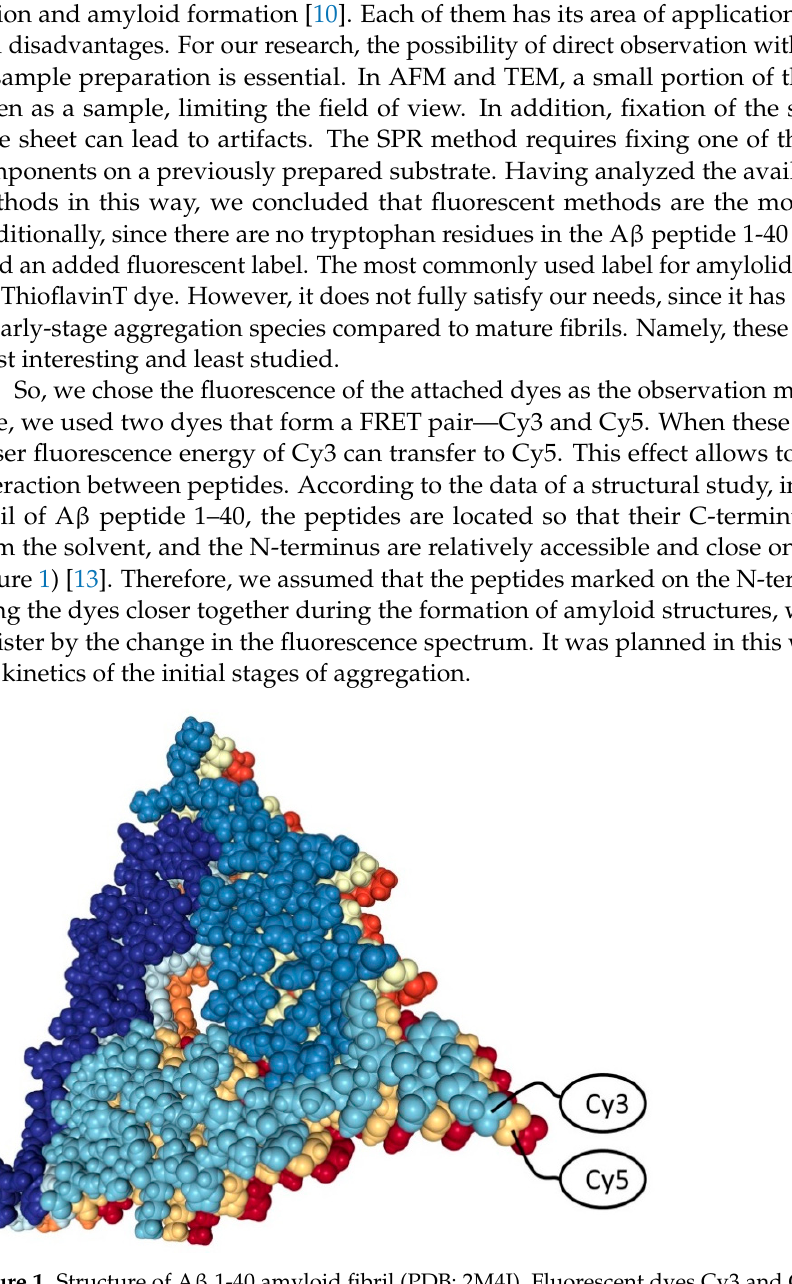
Figure 1. Structure of A β 1-40 amyloid fibril (PDB: 2M4J). Fluorescent dyes Cy3 and Cy5 attached to the N terminus of peptides are schematically indicated.